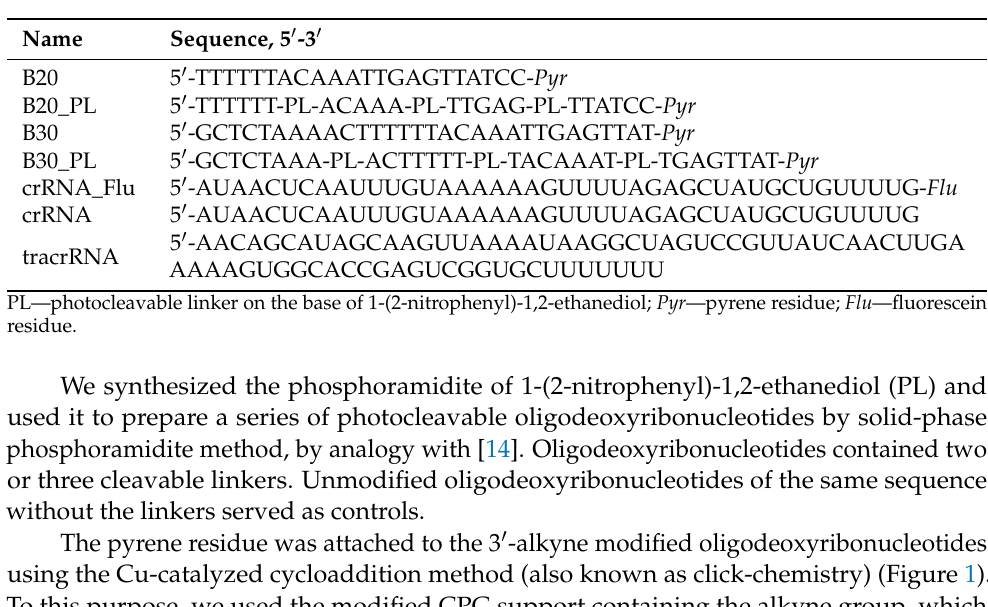
Table 1. Synthetic oligonucleotides used in the study: PC-DNAs and their 3’-pyrene containing conjugates, crRNA, and tracrRNA.